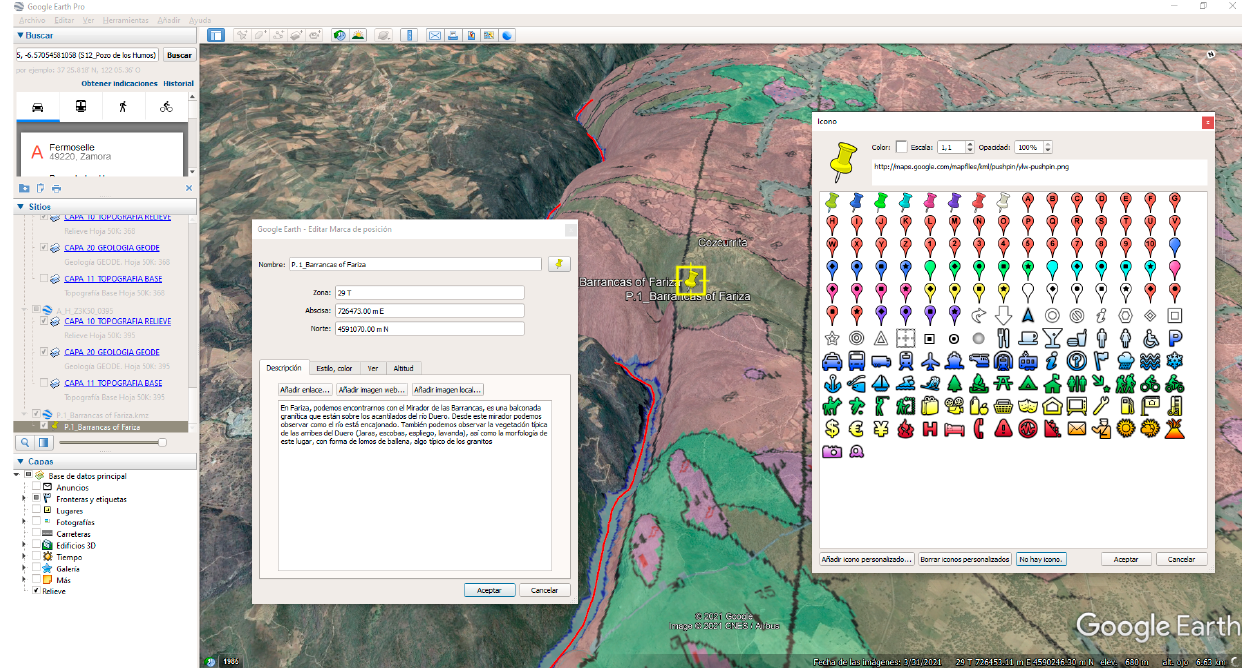
Figure 4. Screenshot of site P-1 (Barrancas de Fariza) with UTM coordinates, description and geological cartography.